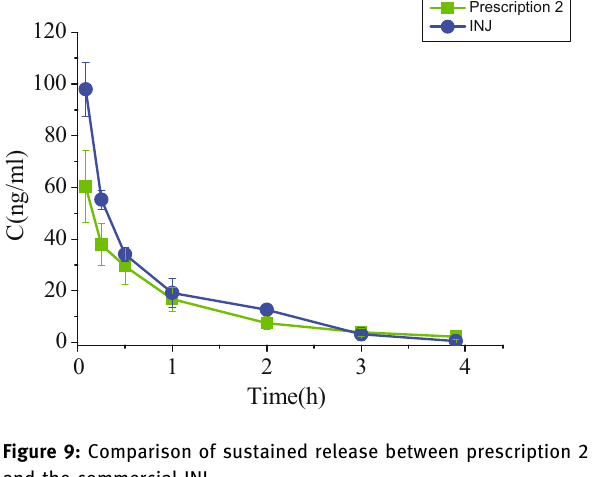
Figure 9: Comparison of sustained release between prescription 2 and the commercial INJ.